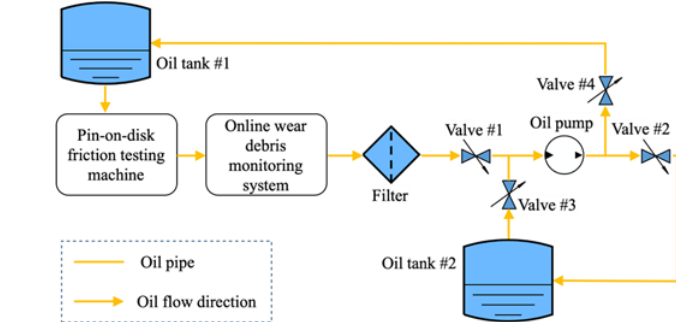
Fig. 4. System diagram of the experimental platform.